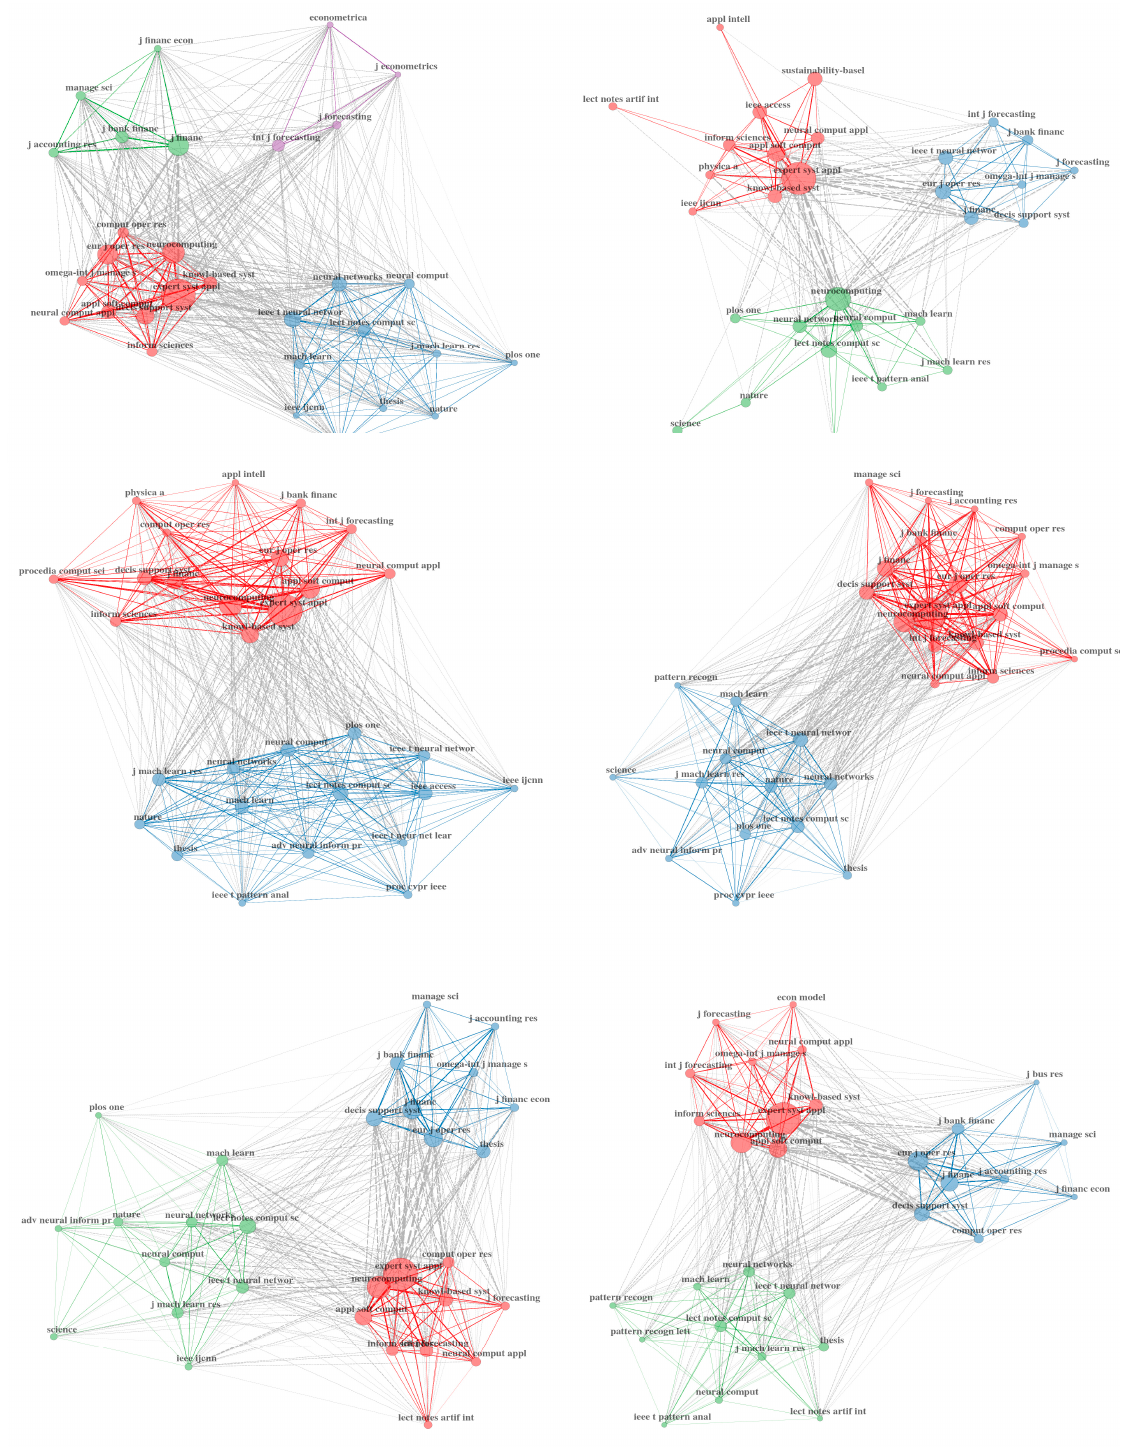
Figure 14. Journals source co-citation analysis, overall period, and per year.